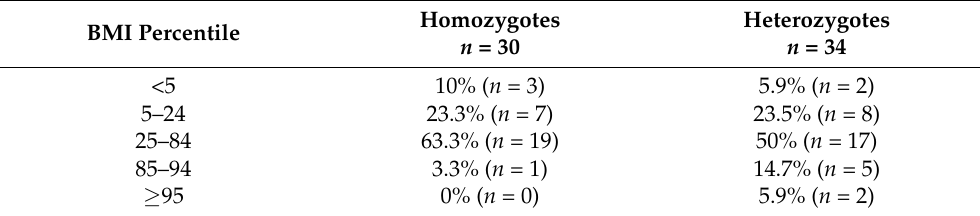
Table 6. Number of individuals in the BMI percentile ranges in the homozygous and heterozygous groups.